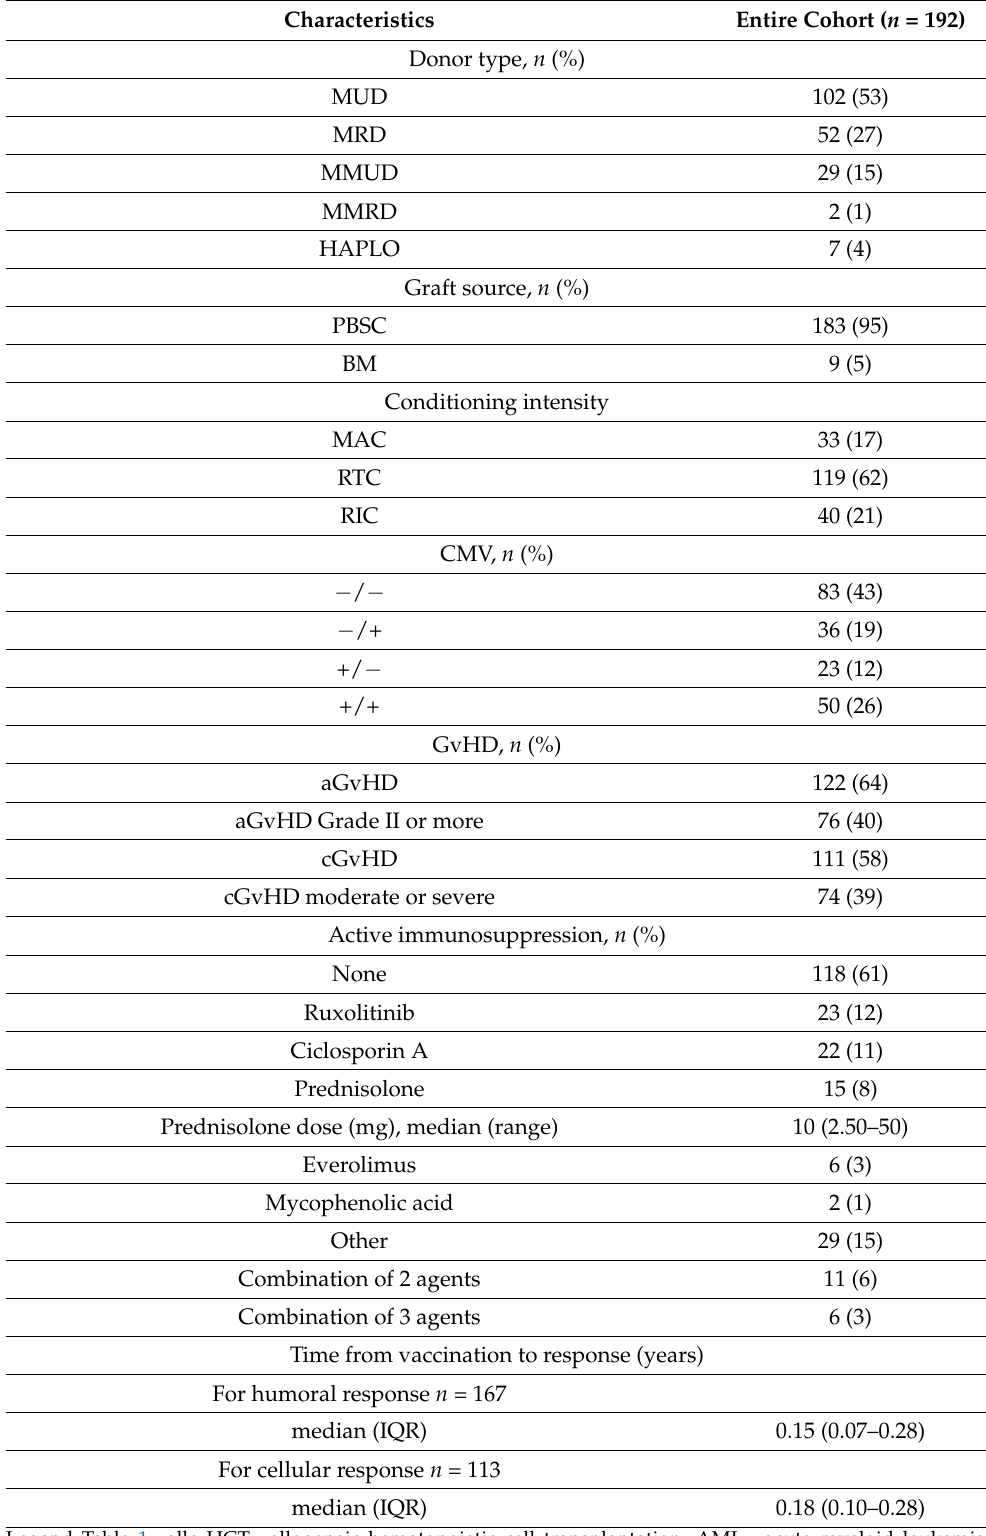
Legend Table 1: allo-HCT—allogeneic hematopoietic cell transplantation, AML—acute myeloid leukemia, ALL—acute lymphatic leukemia, MDS—myelodysplastic syndrome, MPN—myeloproliferative neoplasia,